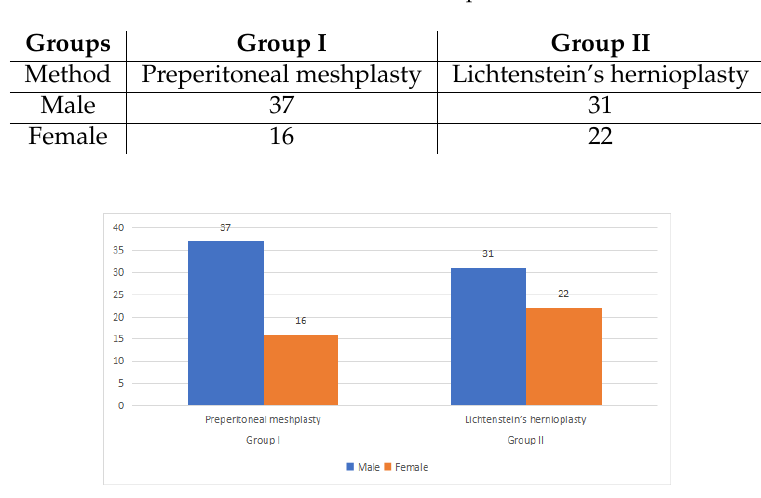
Table 1. Distribution of patients